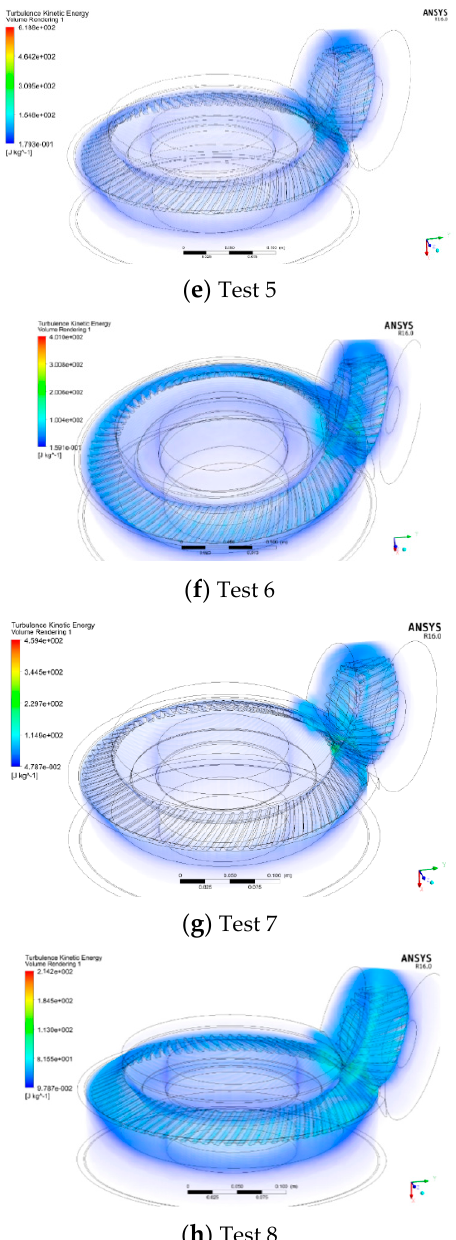
Figure 13. Turbulent kinetic energy inside gearbox.